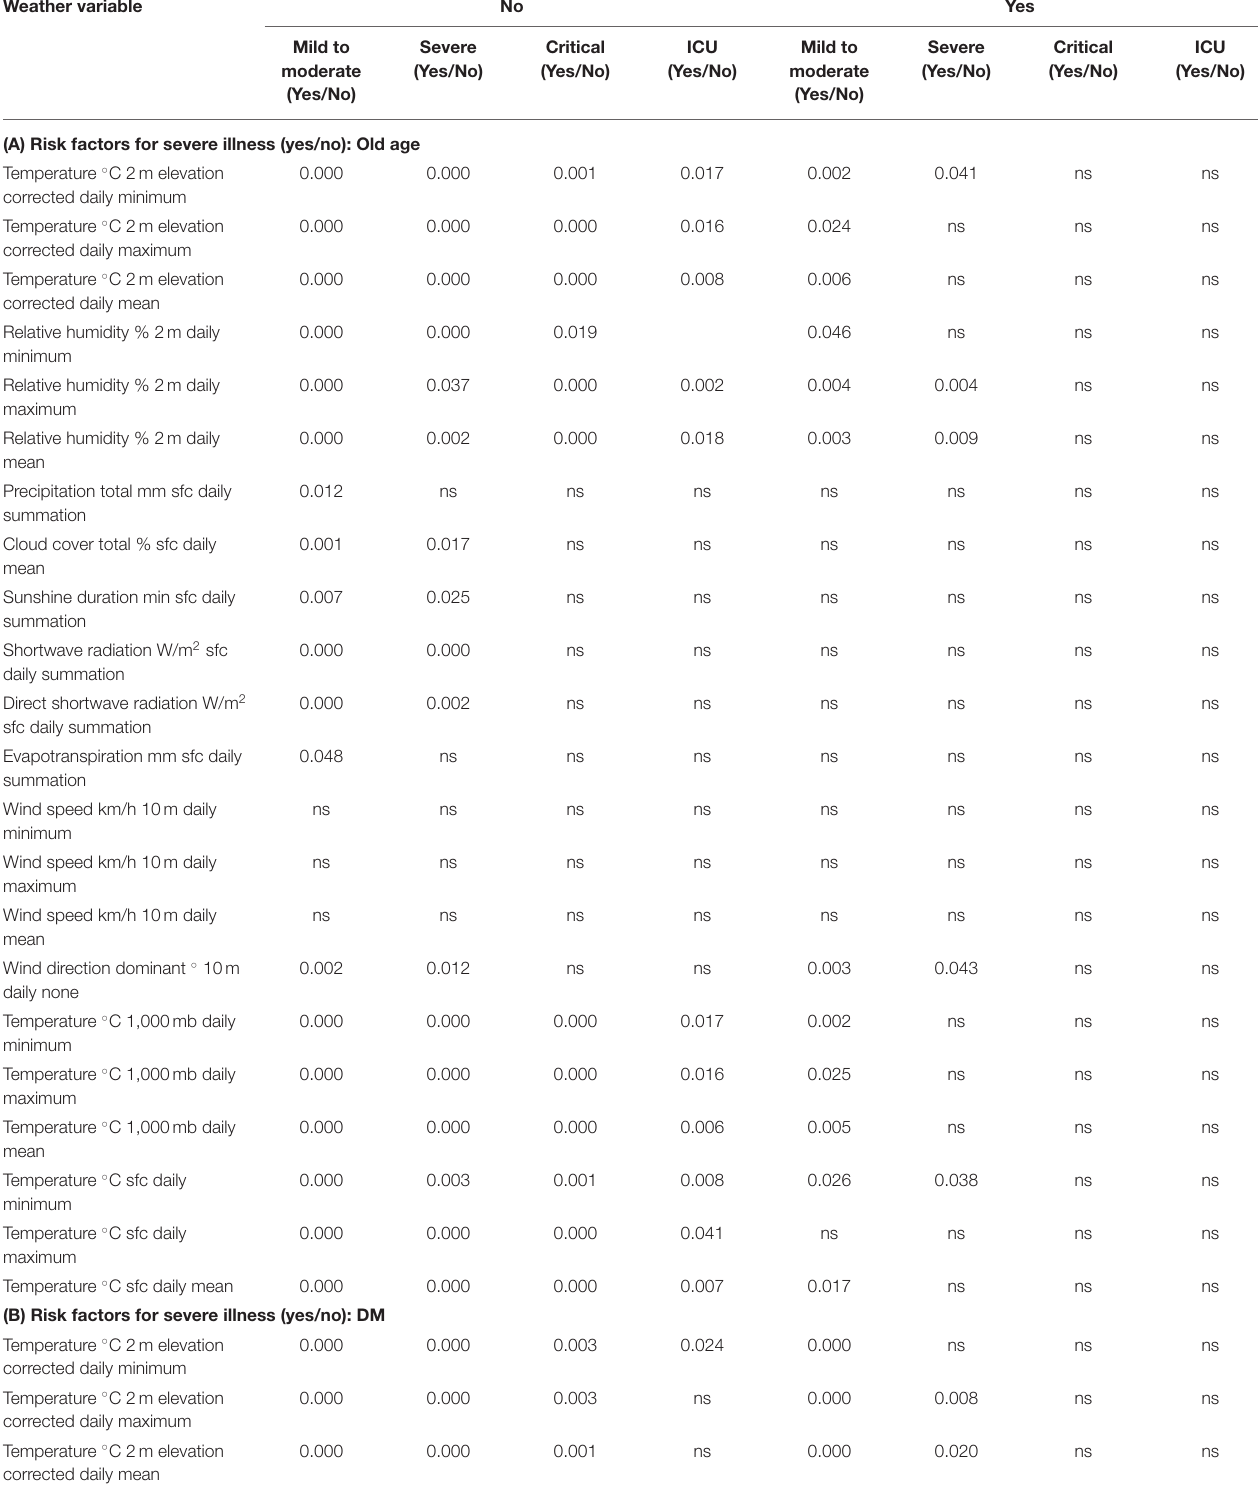
TABLE 2 | Difference in day-of-admission weather variables in Dubai City between COVID-19 patients’ clinical outcomes divided into those with risk factors to develop severe COVID-19 and those without (A: old age, B: DM, C: HTN, D: CVD, or E: chronic lung disease). Weather variable No Yes